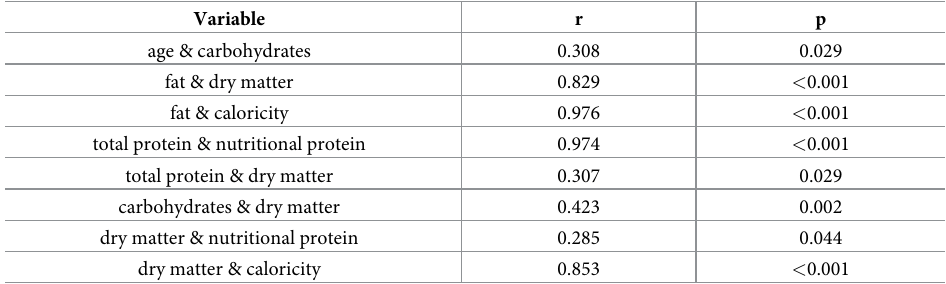
Table 2. Correlations of Spearman rank order significant with p < 0.05 in a group of milk samples from women giving birth before 37 weeks of pregnancy (n =